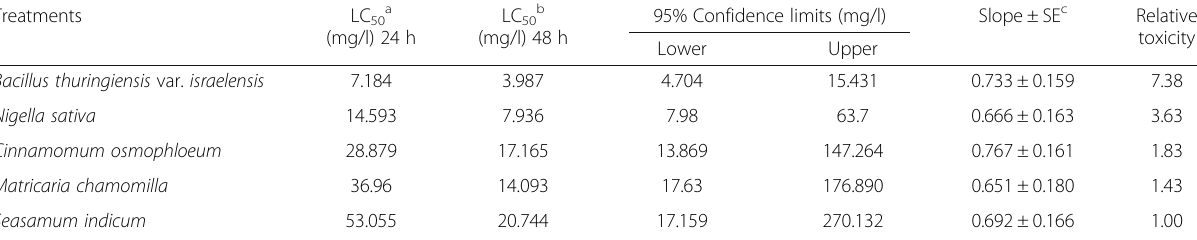
Table 1 Relative toxicity of Bacillus thuringiensis var. israelensis and four plant extracts against Culex quinquefasciatus after 24- and 48-h exposure